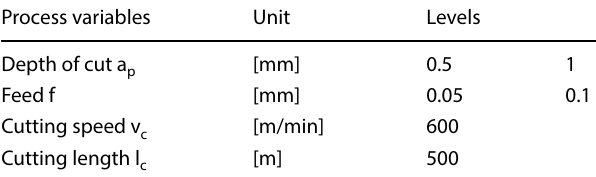
Table 4 Parameter settings of the turning